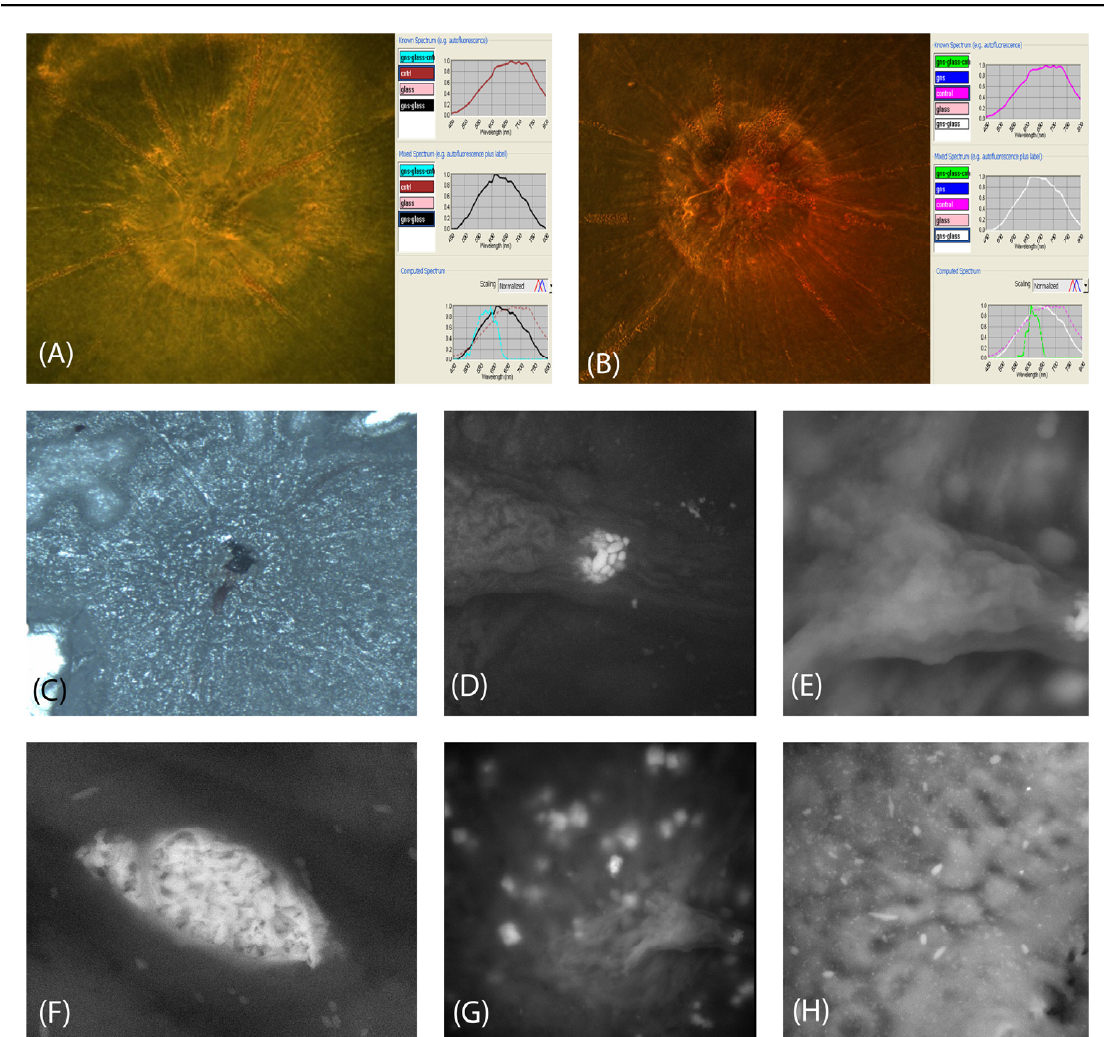
Figure 4. Hyperspectral microscopy. Non-obese, non-diabetic mice injected with intravenous GNPs. Hyperspectral dark-field × 200 imaging shows spherical GNPs ( A ) and rod-shaped GNPs ( B ) in the tissue but not in the vasculature. Air scan electron microscopy. DMT1 mouse following GNP injection. The low-magnification image ( C ) shows the entire retina with the optic nerve at the center. ( D – G ) Hyperfluorescence can be seen from cells and from GNPs in the tissue but not in the microvasculature ( H ). 2.7. Reduced Gliosis and Retinal Edema following Intravitreal Injection of